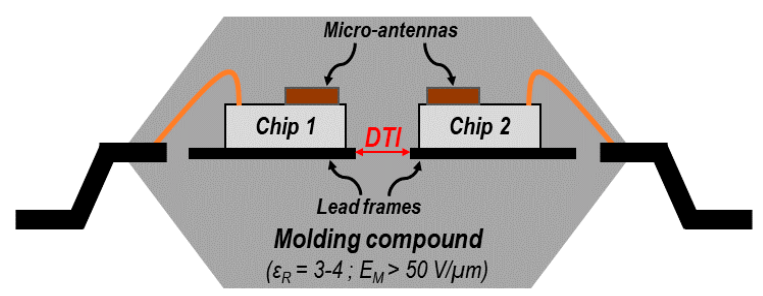
Figure 2. Side-by-side co-packaged chips with RF coupled planar micro-antennas.